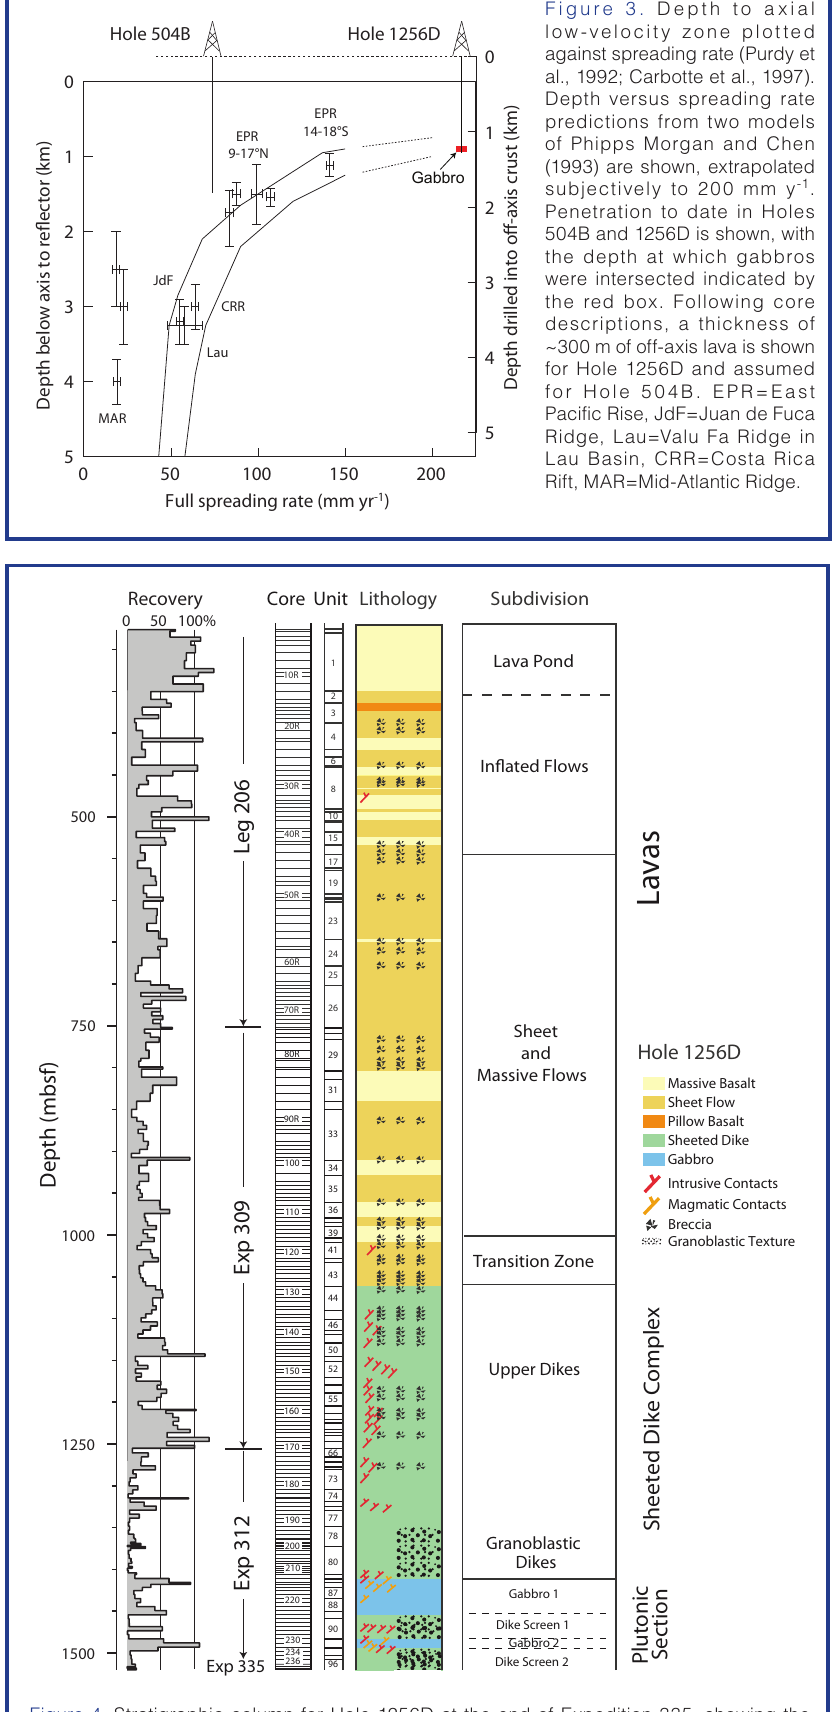
Figure 4. Stratigraphic column for Hole 1256D at the end of Expedition 335, showing the major and minor lithologic divisions of the upper ocean